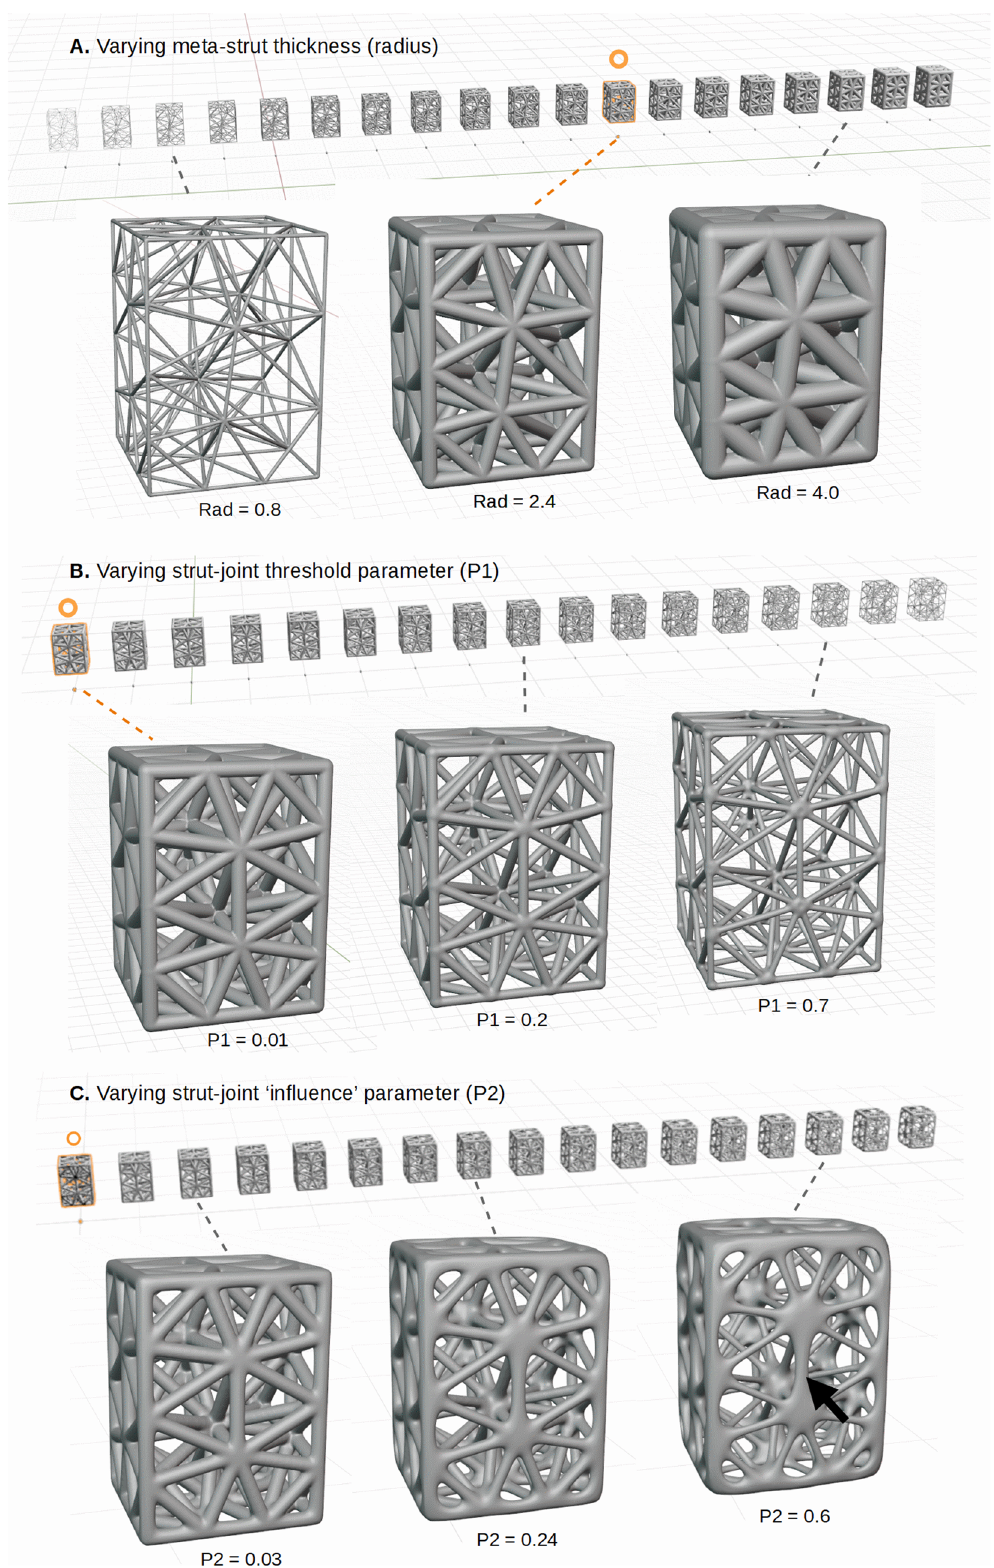
Figure 6. Examples of variations in three main meta-structure parameters: ( A ) strut radius, ( B ) strut-joint threshold, and ( C ) strut-joint tolerance or ‘influence’. Strut radius has the most effect on overall HGon volume change. Threshold (P1) controls the meta-boundary and enables struts to be thinned while retaining joint thickness. Influence/tolerance (P2) controls the blending of struts and joints, enabling enhanced chamfer control. High influence values (> 0.7) can lead to large joints and high tapering of struts (black arrow), which can be interesting for uniquely optimized high strength designs for AM-3D printed components. The circles indicate reference structures for subsequent volume calculations/plots shown in the next figure (Fig.